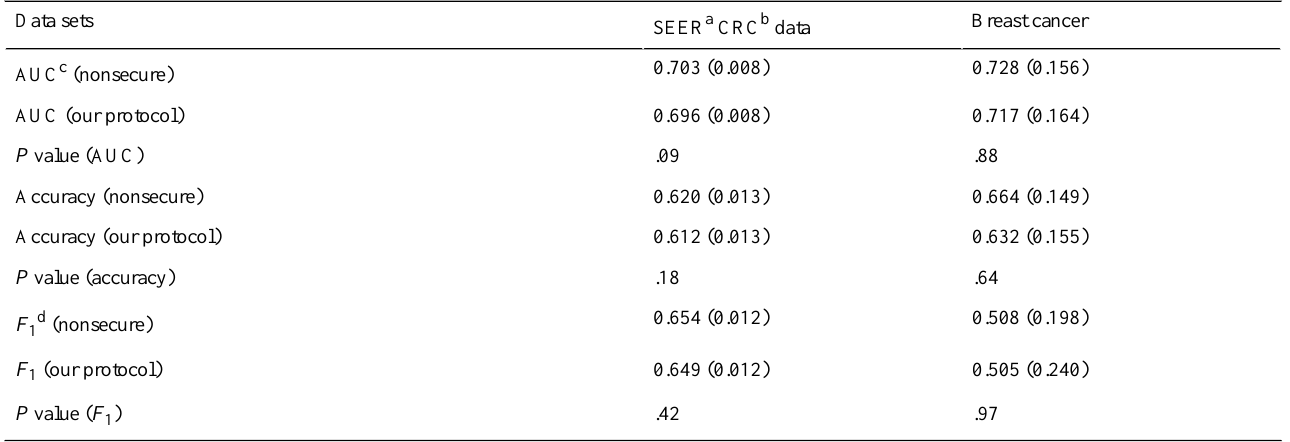
Table 3. Accuracy comparison between nonsecure and proposed secure logistic regressions.